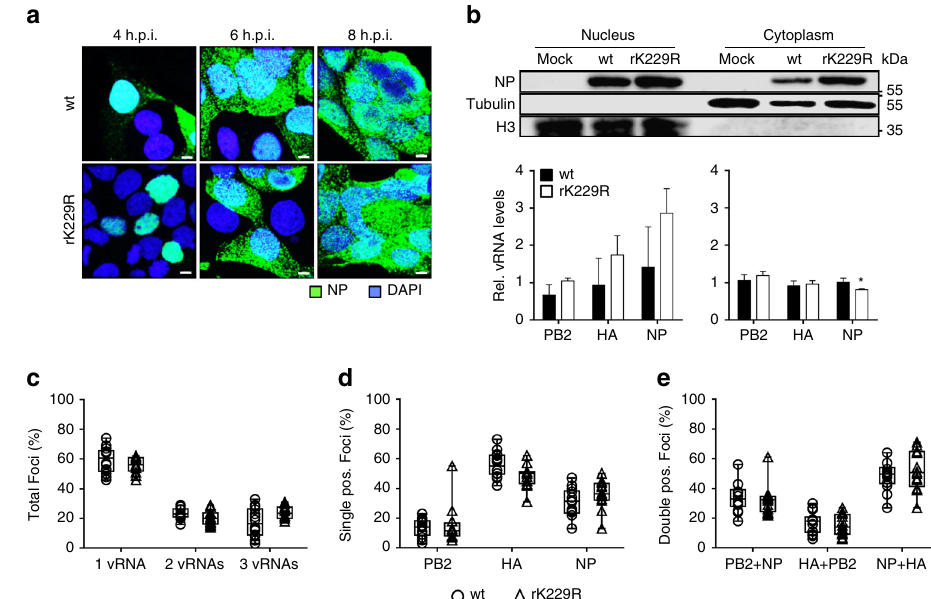
Fig. 2 Growth de fi ciency of NP mutant virus rK229R. a Subcellular localization of NP in MDCK II cells infected with the indicated viruses at an MOI of 5 after 4, 6 and 8 h.p.i. Scale bar = 4 µ m. b Cytoplasmic and nuclear accumulation of viral protein and RNA. MDCK II cells were infected at an MOI of 5 and 6 h.p.i., nuclear and cytoplasmic fractions were obtained. Upper panels show protein levels determined by Western blot analysis. β -Tubulin and histone H3 were used as markers for speci fi c fractionation. Lower panels: relative vRNA transcript levels (PB2, HA, NP) in the nuclear and cytoplasmic fractions determined by quantitative RT – PCR. * p < 0.05. Error bars indicate the mean and s.d. of at least three independent experiments. Student ’ s t -test was used for two-group comparisons. c – e Fluorescence in situ hybridization to examine co-segregation of vRNAs in wt SC35M and rK229R-infected cells. MDCK II cells were infected at an MOI of 5 for 6 h and vRNAs were subsequently stained with segment-speci fi c and fl uorescently labeled probes. c Total cytoplasmic foci, positive for either one (HA, NP or PB2), two (HA and NP; HA and PB2; NP and PB2) or three vRNAs (HA, NP and PB2). d Composition of cytoplasmic foci positive for only one vRNA. e Cytoplasmic foci, positive for two co-segregating vRNAs. Each dot represents the total cytoplasm of a single cell. Depicted are 12 – 14 infected cells per virus from > 4 independent infections. A two-tailed Mann – Whitney test was used for two-group